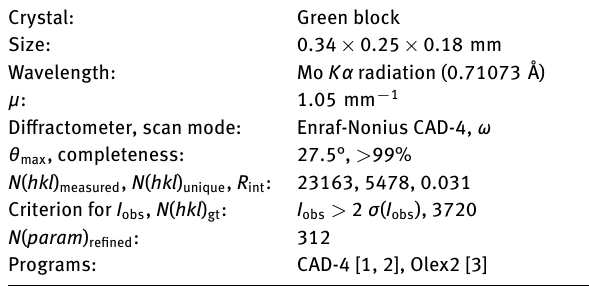
Table 2: Fractional atomic coordinates and isotropic or